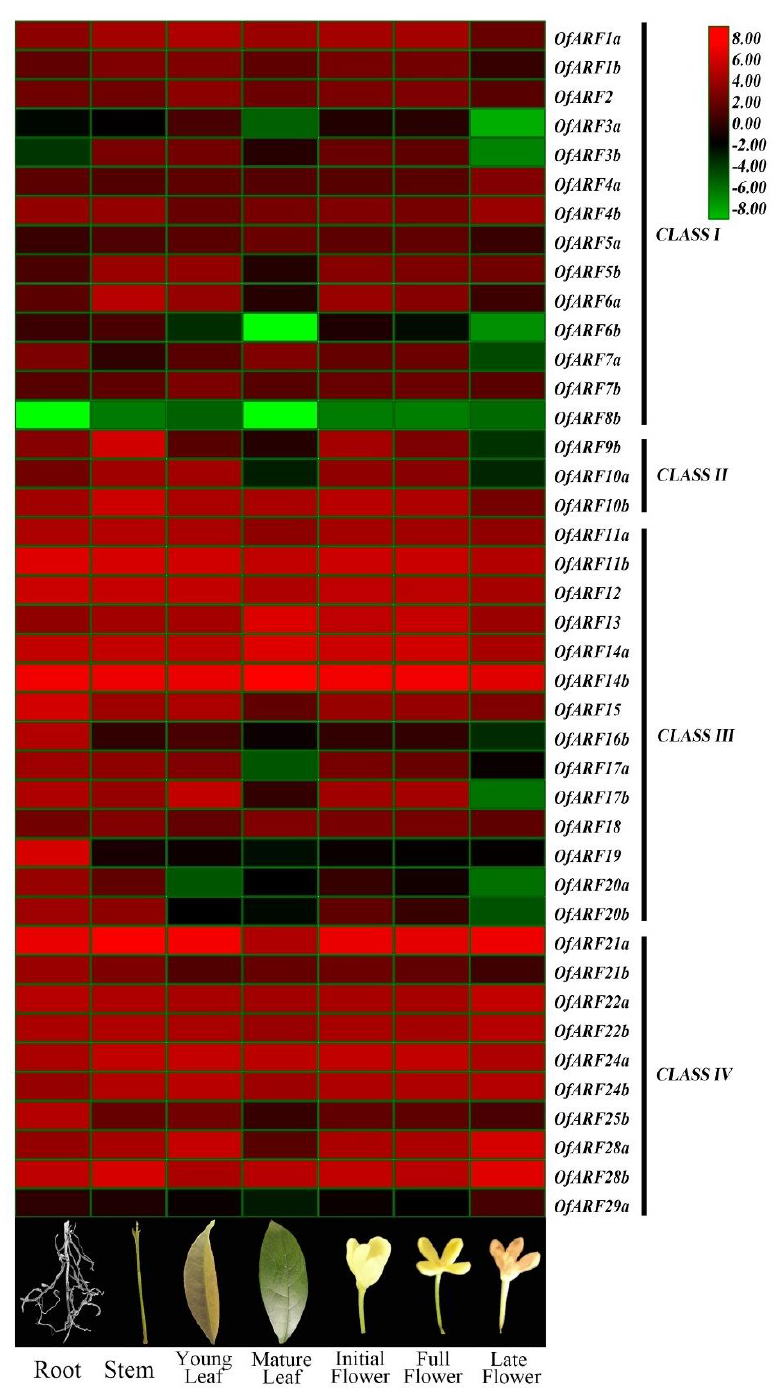
Figure 8. Heatmap of Osmanthus fragrans auxin response factor ( OfARF ) gene expression in three flower developmental stages and various tissues. Levels of down expression (green) or up expression (red) are shown on a log2 scale from the lowest to the highest expression of each OfARF gene. Reads per kilobase of transcript per million mapped reads (RPKM) values of OfARF genes were normalized by log 2 transform and the heatmap was constructed by TBtools software.